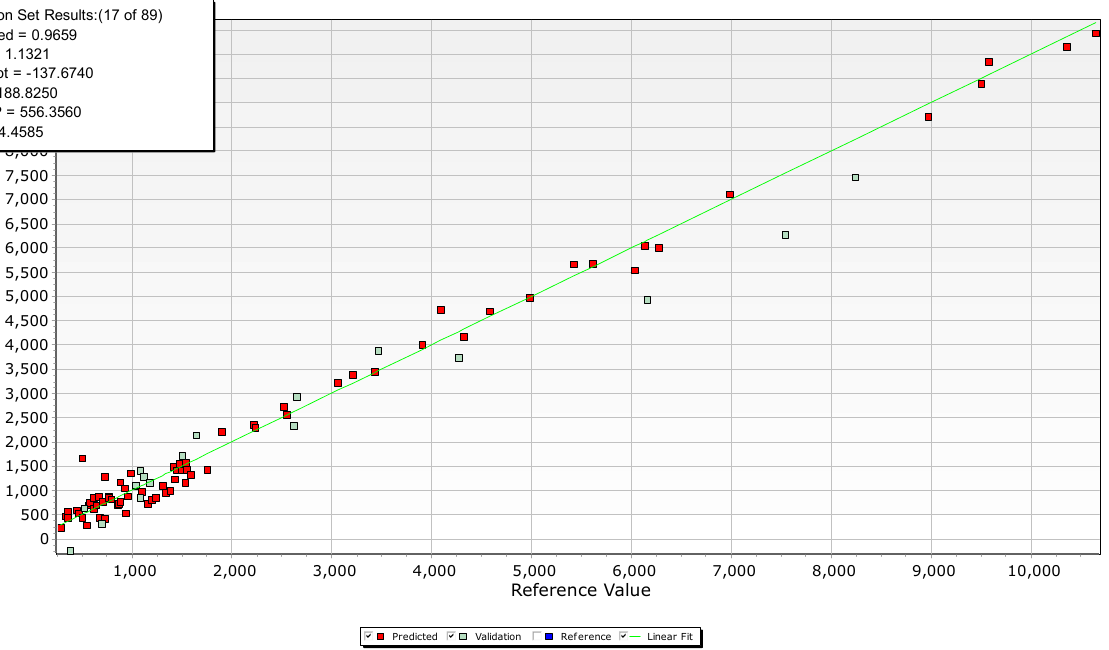
Figure 11. PLS regression coefficients for antimony concentration in concentrates. The coefficients identify the parts of the diffractogram contributing most to the PLSR regression model. Table 4. 2theta angles in the diffraction pattern of copper concentrates with the highest regression coefficient for the PLSR model of antimony, and diffraction peaks of the corresponding phase. °2 θ